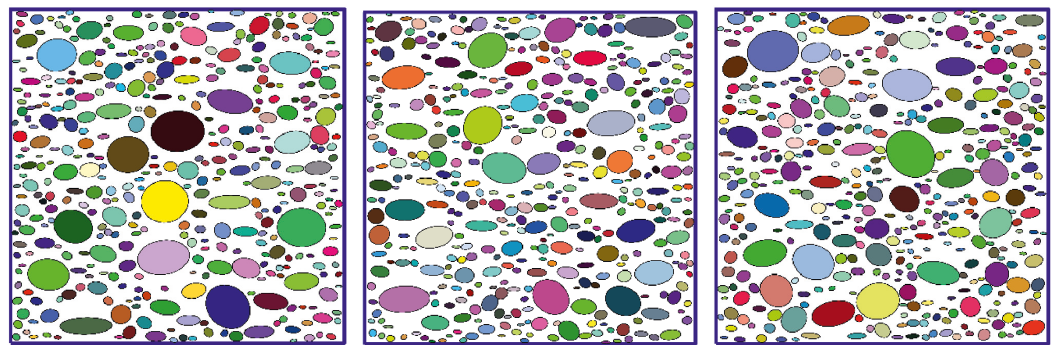
� 0.475, r � 4, Q � 35.5%). min max s